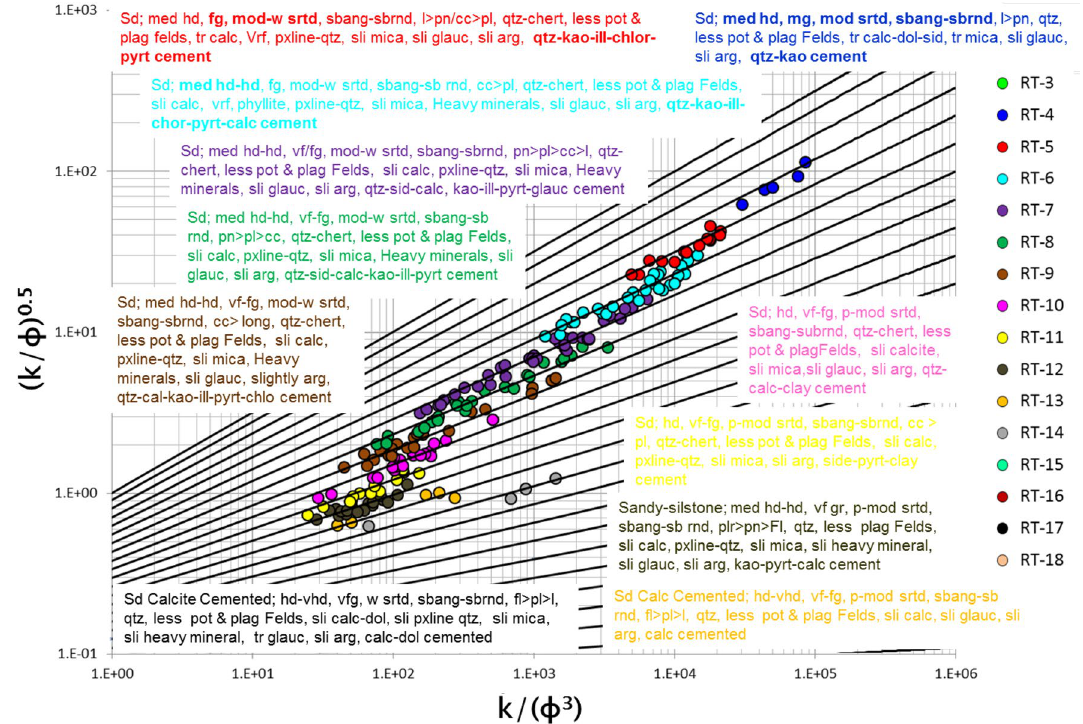
Fig. 1 Identification of the rock type based on pore geometry and pore structure for data set 1 (Prakoso et al.